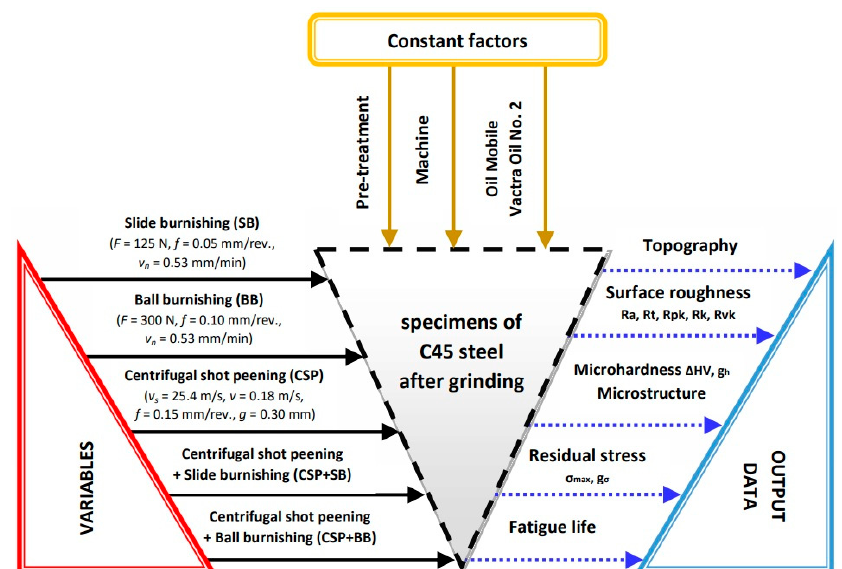
Figure 1. Schematic diagram of the experiment carrie d out.